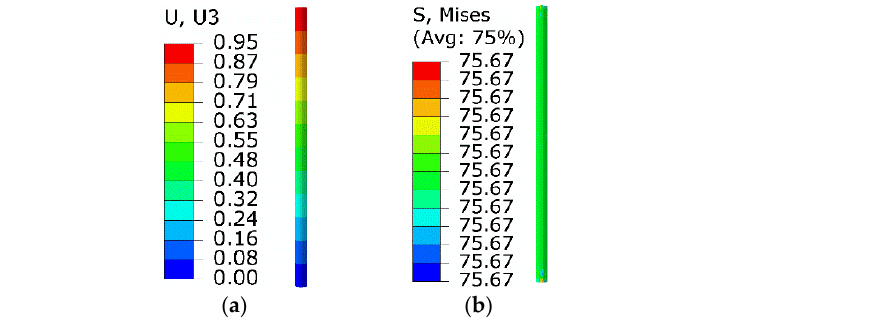
Figure 7. Results of step 3: ( a ) axial displacement; ( b ) equivalent stress.